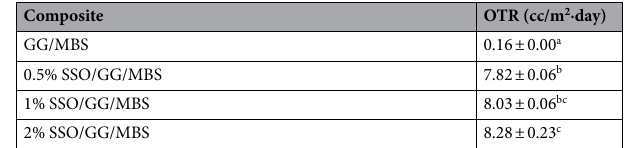
Table 3. Oxygen transmission rate (OTR) of GG/MBS and SSO/GG/MBS composite films. Data expressed as mean ± standard deviation of five replicates. Different lowercase letters (a–c) in the same column indicate a significant difference ( P ≤ 0.05) by Duncan’s multiple range test. GG guar gum, MBS mung bean starch, SSO sunflower seed